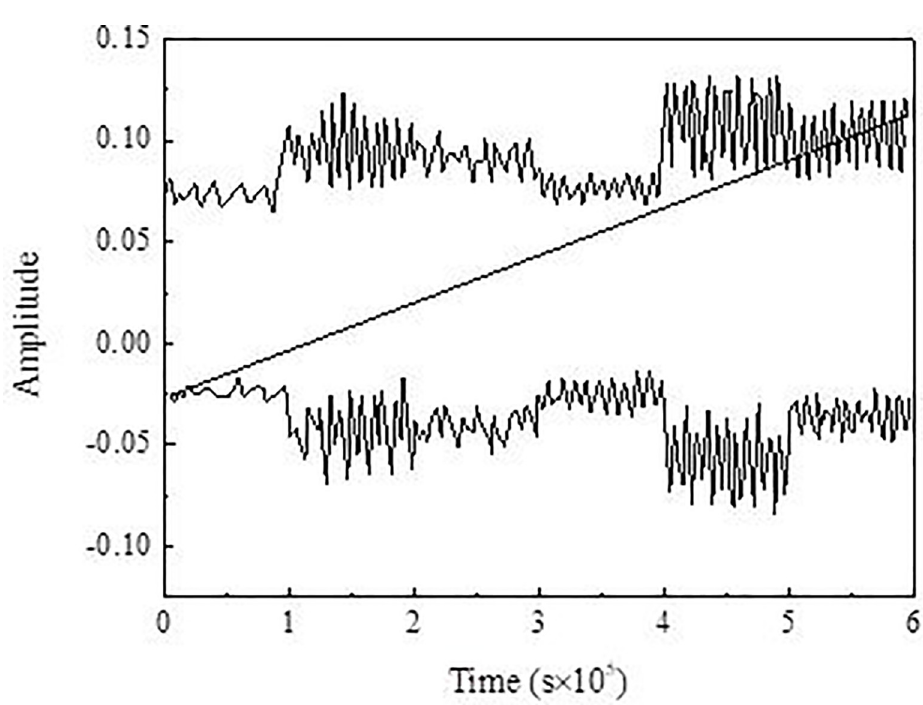
Fig 4. Specific distribution of vibration time-domain signals of